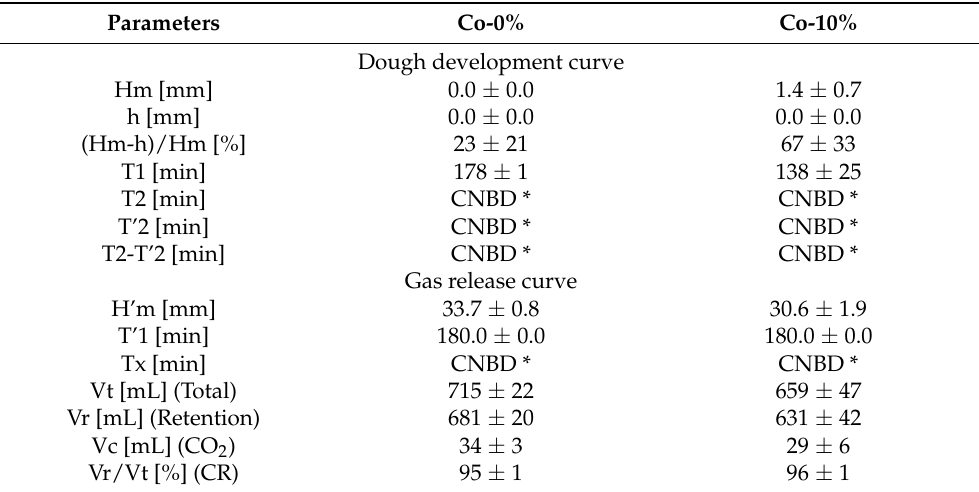
Table 4. Results (M ± SE) from the dough development curve and gas production curve for corn flour without (Co-0%) and with the addition of 10% of edible insects (Co-10%) using the device rheofermentometer RF-4 (Chopin, France). Parameters Co-0% Co-10% Dough development